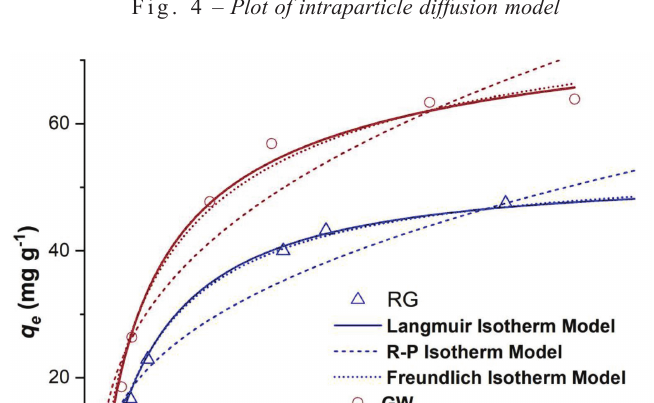
Fig. 4 – Plot of intraparticle diffusion model